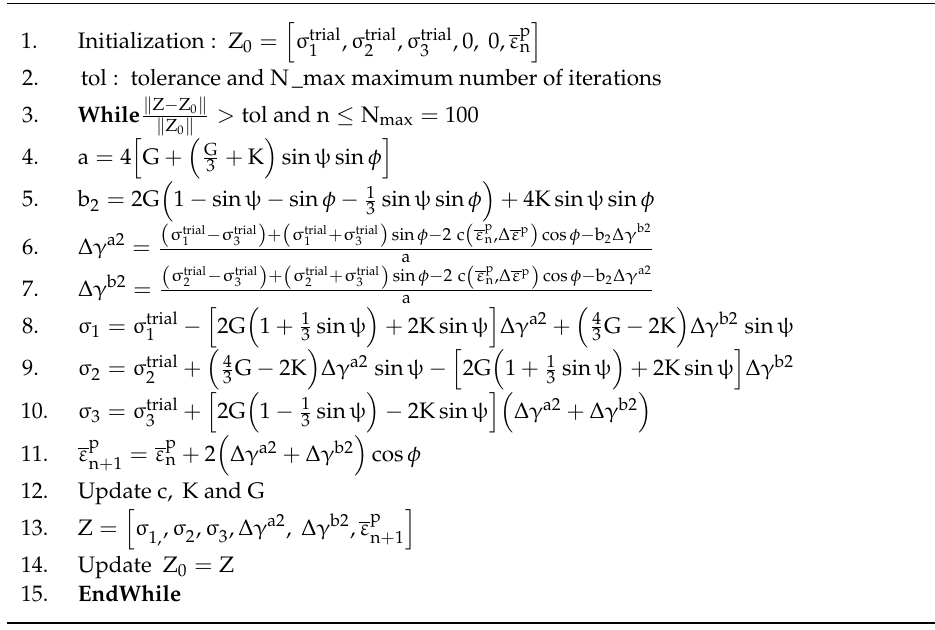
Algorithm 5 : Fixed point algorithm applied to the left edge